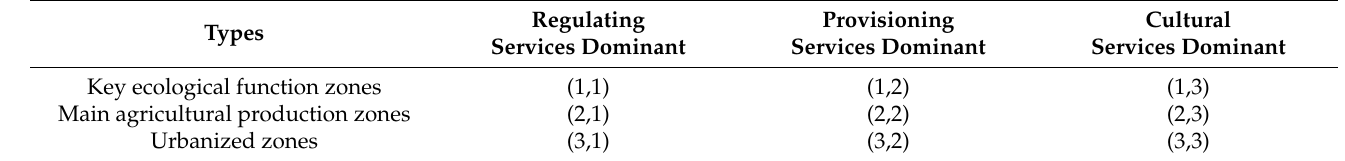
Table 1. Matrix of the relationship.